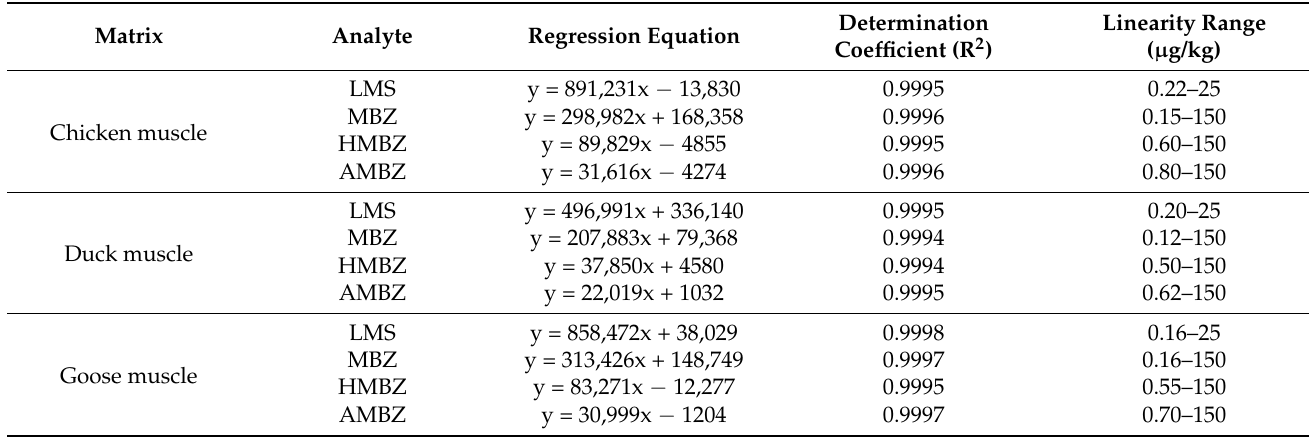
Table 3. The linear regression equation, determination coefficient and linearity range of LMS, MBZ, HMBZ and AMBZ in poultry muscle.